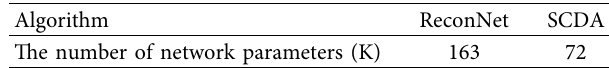
Table 12: The number of network parameters for 10 images (the measurement rate is 0.01).